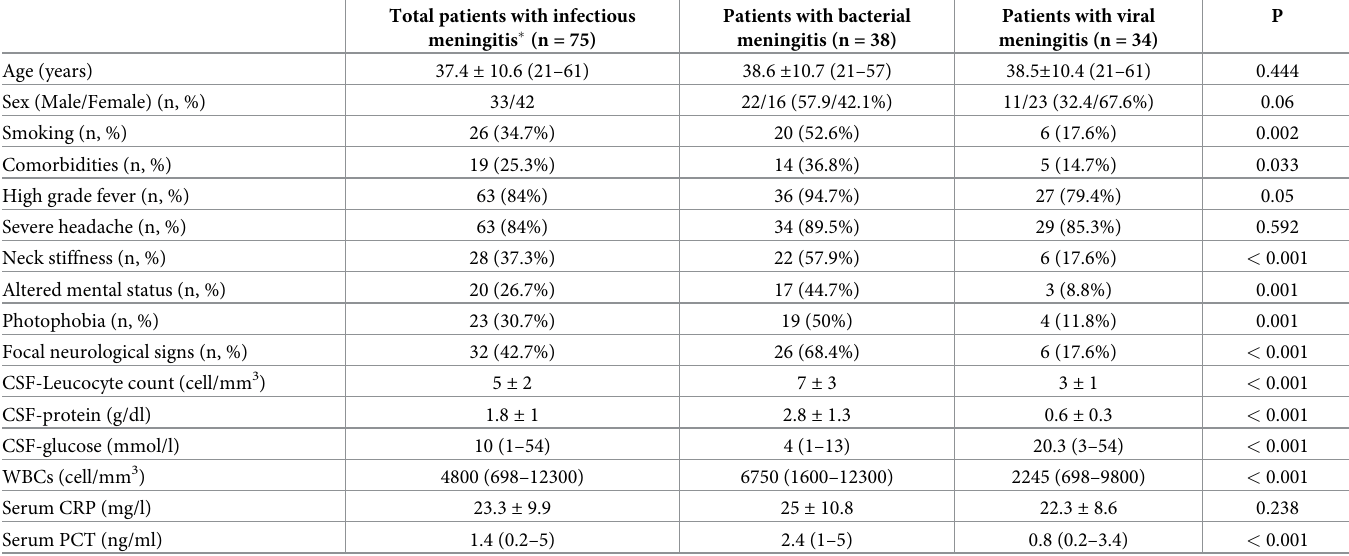
Table 2. Sociodemographic and clinical data of patients with infectious meningitis.